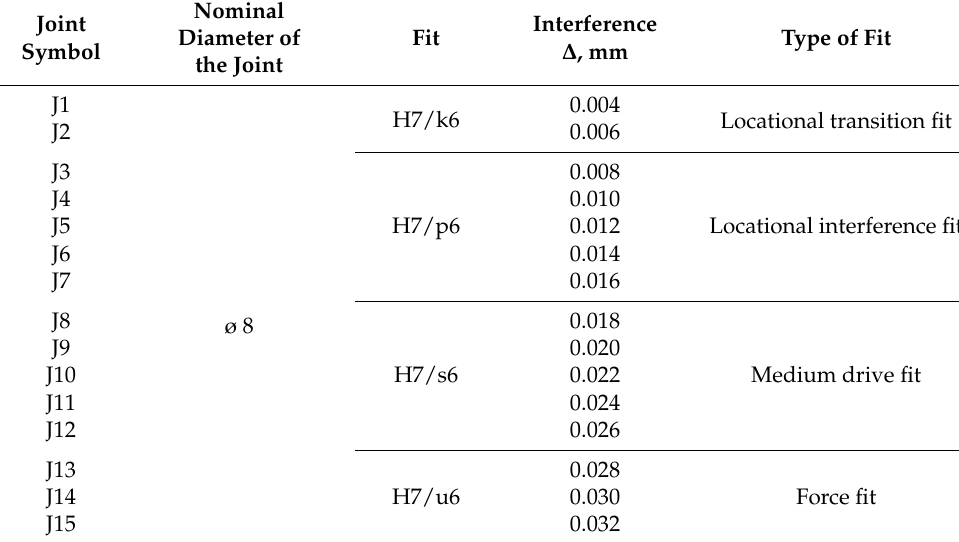
Table 1. A list of